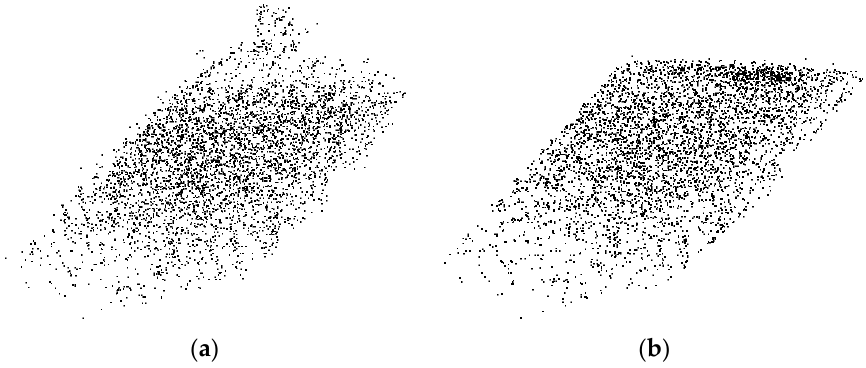
Figure 9. Comparison of the original planar point cloud and the projected point cloud. ( a ) The original planar point cloud. ( b ) The projected planar point cloud.